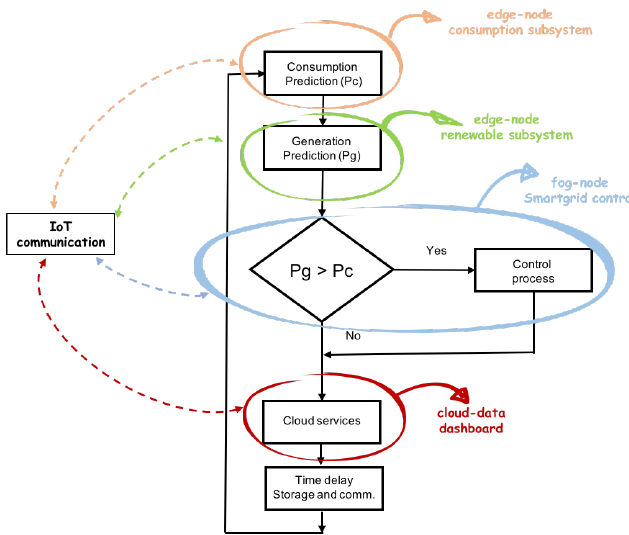
Figure 19. Processes installed in different devices integrated in the model. The figure shows their integration using a flow diagram. Each process designs and develops the applied services of detection, classification, or prediction in different nodes. These nodes can be edge or fog nodes, depending on the type of objective. The figure shows how the generation node and the consumption node provide the necessary data so that the load activation control process can act or